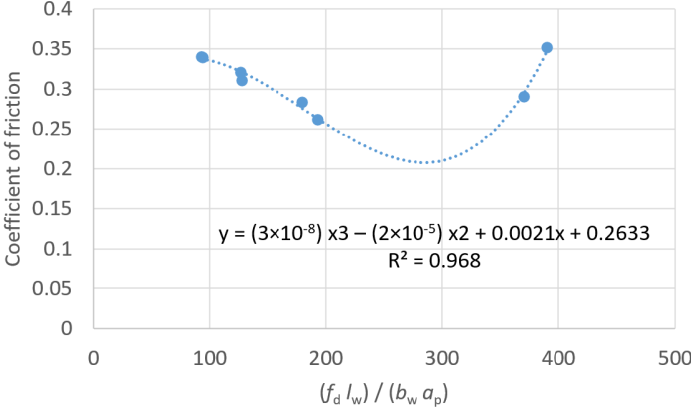
Figure 9. Surface COF expressed as a function of microstructural geometrical features ( f d l w )/( b w a p ). The observation presented in Figures 8 and 9 are under the friction test condition A.